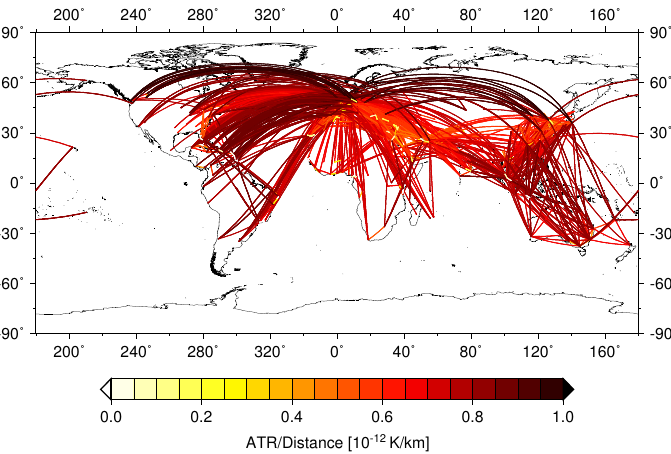
Figure 6. ATR (Average Temperature Response) per route and km for reference cruise